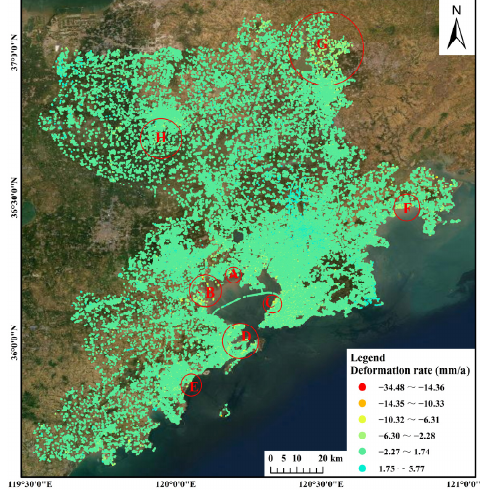
Figure 8. Distribution of subsidence areas.